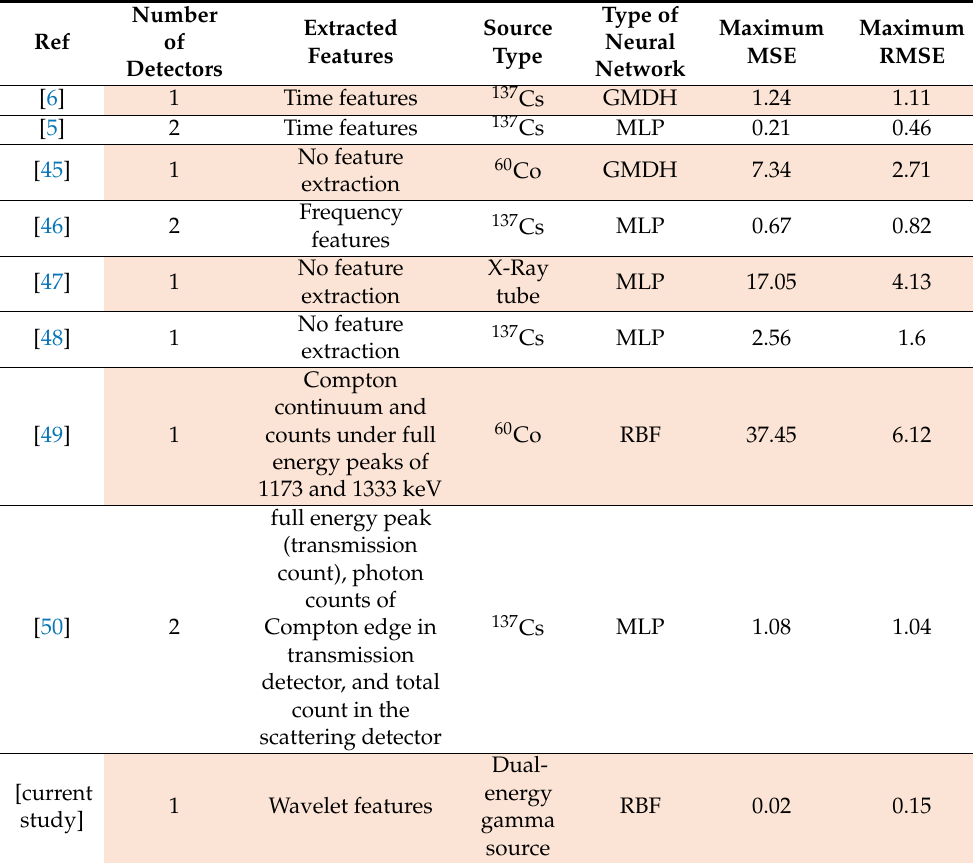
Table 2. A comparison of the accuracy of the proposed detection system and previous